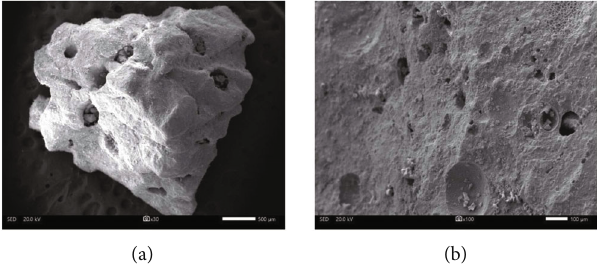
Figure 8: Coral sand particles and coral sand mortar erosion interface: (a) sand particles and (b) mortar erosion